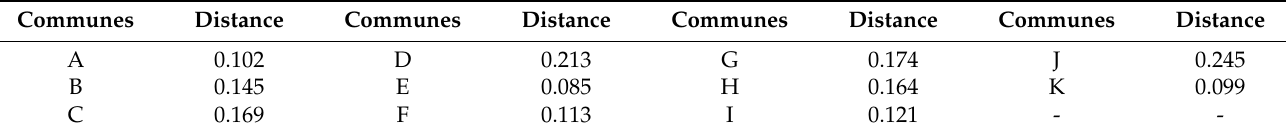
Table 13. Object distances from the reference object.